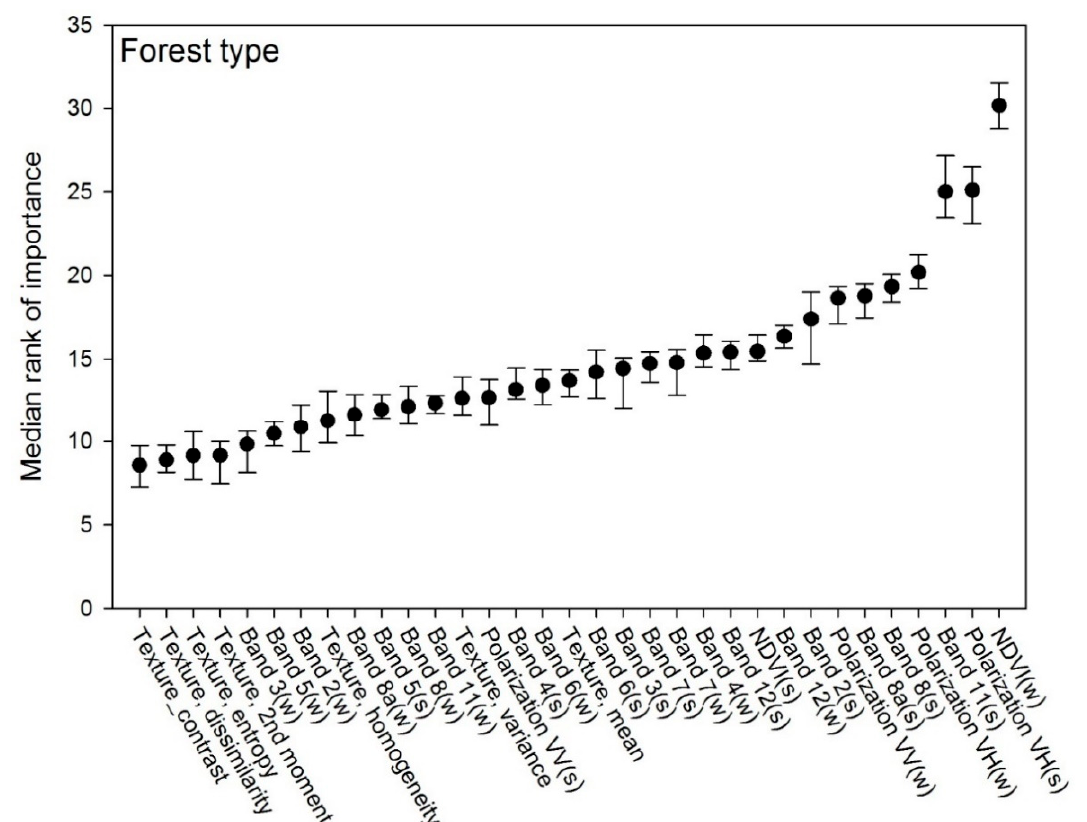
Figure 3. Input features for predicting forest type in Denmark 2018 ranked after importance by the Boruta simulations. Table 3. Confusion matrix and producer (PA), user (UA), and overall (OA) accuracy statistics of the forest type classification based on the independent evaluation data. Entries in the matrix represent the number of pixels and proportions in brackets. Forest area distribution to forest types and the corresponding 95% confidence interval (CI 95%) are based on the post-filtered forest area estimate (Table